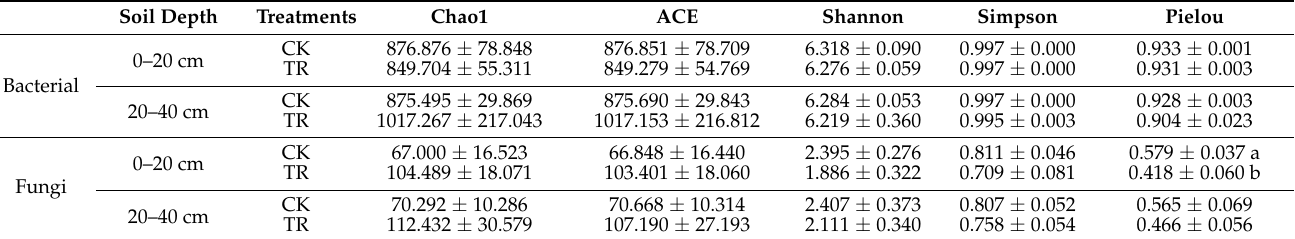
Table 2. Diversity indices of fungal and bacterial community in Eucalyptus plantations.